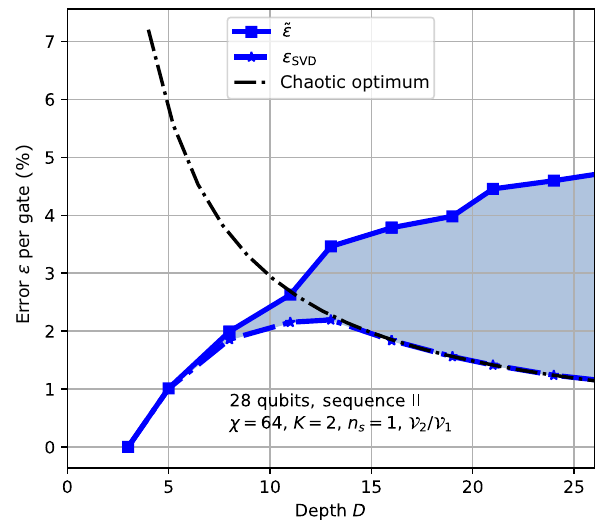
FIG. 9. Comparison of the error per gate to the SVD error as a function of depth D . Vertical qubit grouping V 2 . The chaotic optimum is Eq.